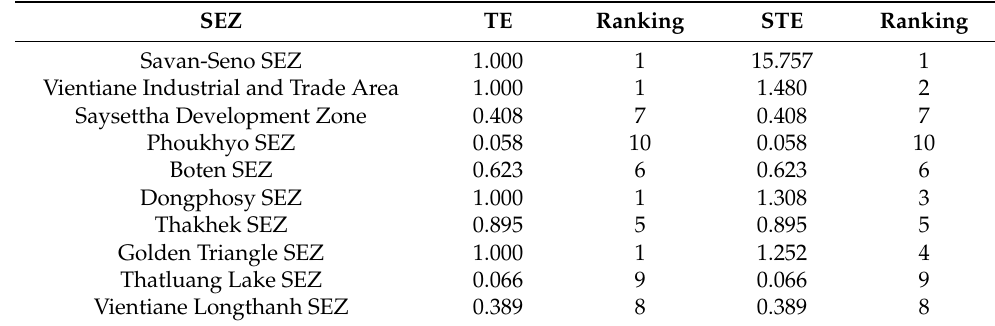
Table 4. Comparison of the TE and STE results of the land use in Laos’ SEZs.